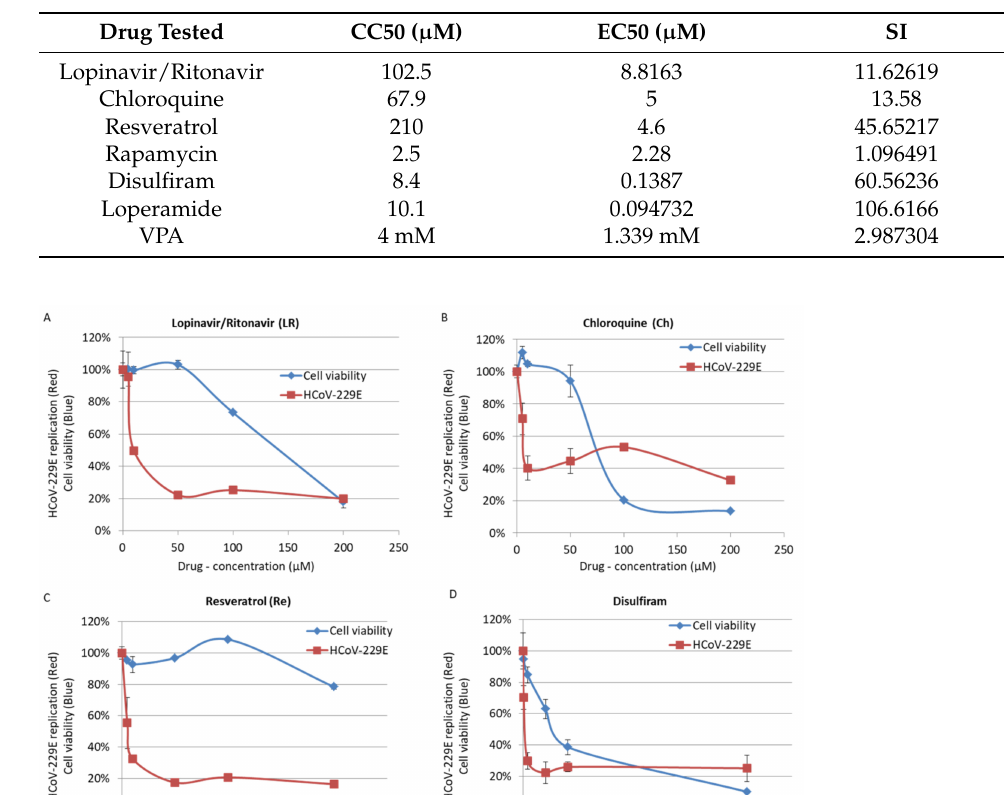
Table 1. The 50% effective concentration (EC50), cytotoxic concentration 50 (CC50) and selectivity index (SI) for the seven drugs tested for human coronavirus (HCoV)-229E replication in MRC5 cells.